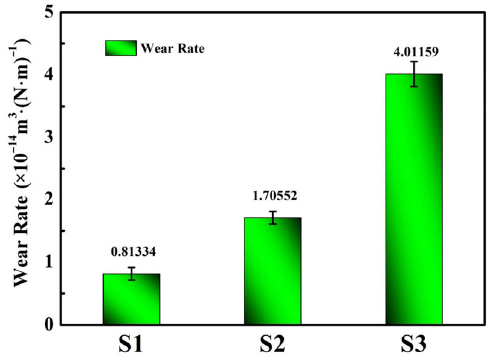
Fig. 9 Wear rate of different samples.